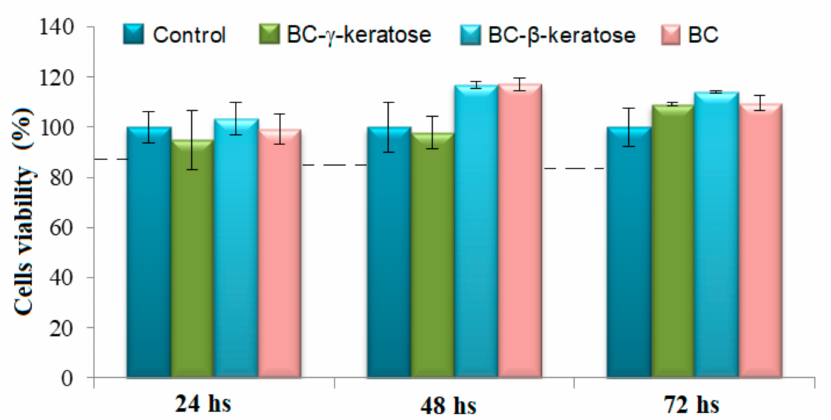
Figure 7. Cell viability data for BC-keratose scaffolds (MTT assay at 24 h, 48 h, and 72